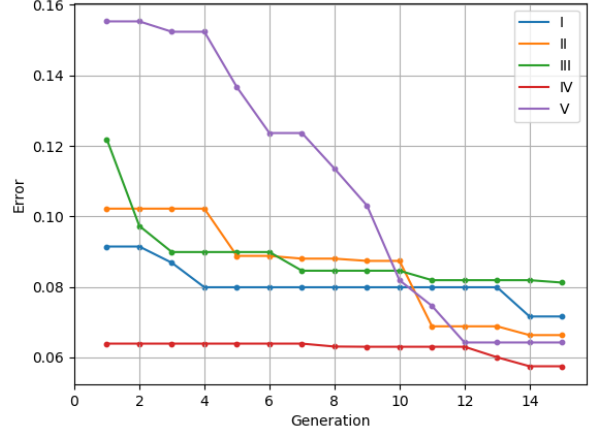
Figure 8: Comparison of best individuals’ error in each generation.